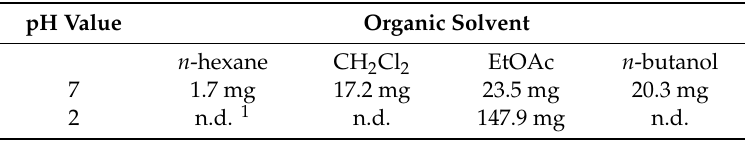
Table 1. Yield (mg) of organic extracts obtained from the aqueous stock extract (40 mL) of mugwort plants using solvents with di ff erent polarity and di ff erent pH